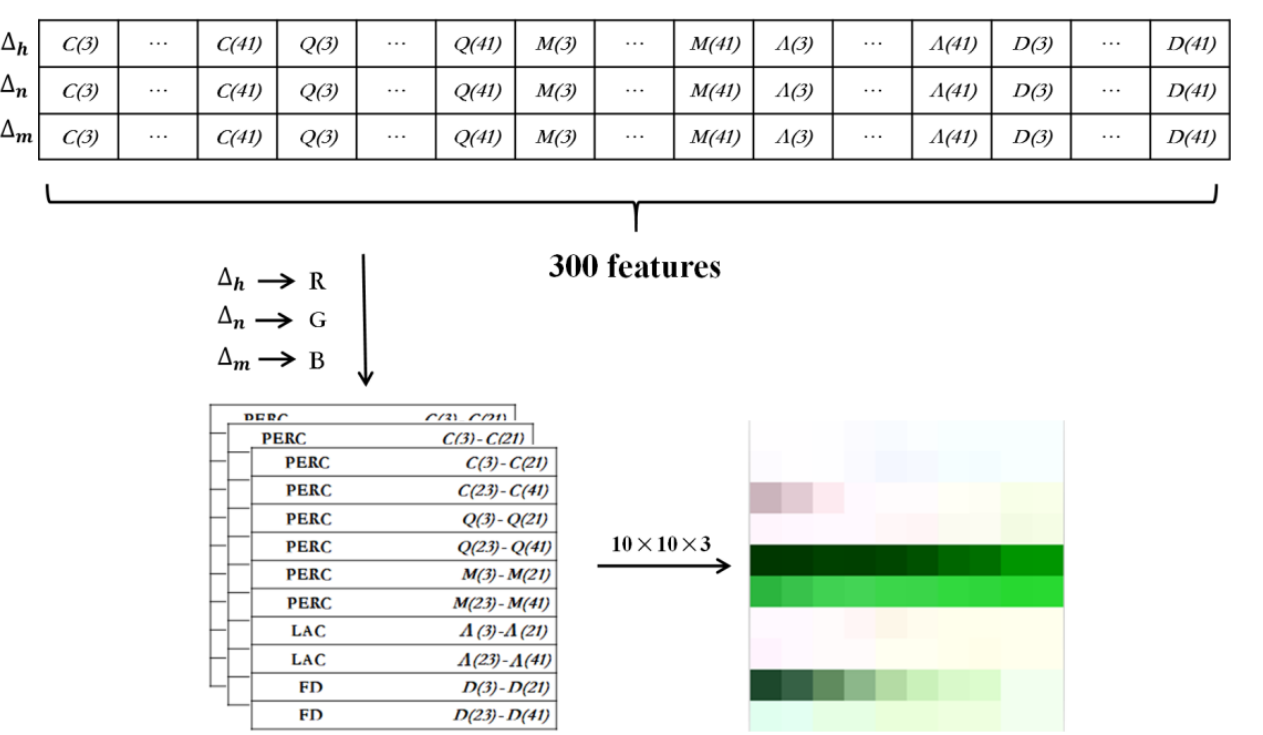
Figure 2. In the process of fractal feature recombination, 300 features were obtained from the five functions of the FD, LAC, and PERC, and these features were reconstructed into 10 × 10 × 3 RGB images. However, the Minkowski distance also changes due to different p values. The Minkowski distance is an extension of the Euclidean distance. When p is 2, it results in a Euclidean distance. With changing values of p , 100 different features could be obtained. We randomly selected one image from each category. It showed that the standard deviation of the feature reached the maximum when p equaled 3. This also indicated that the range of the features was the largest, as shown in Figure